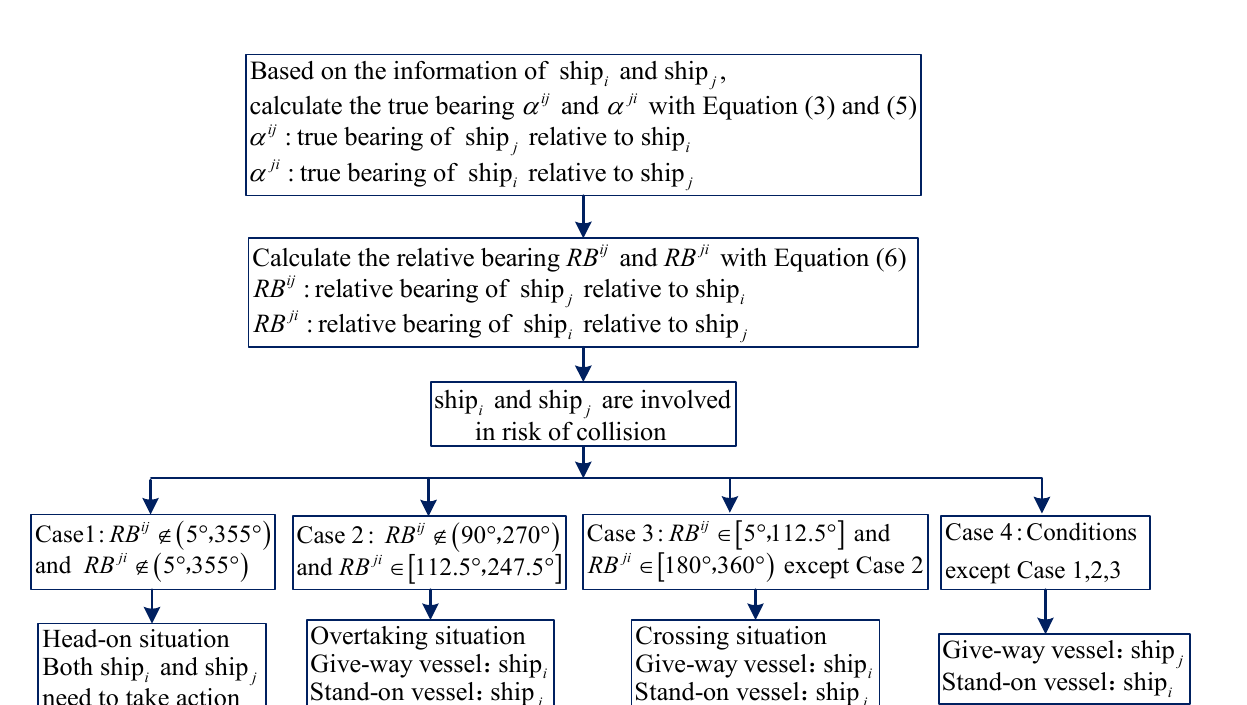
Figure 1. The identification of collision situation and responsibility.